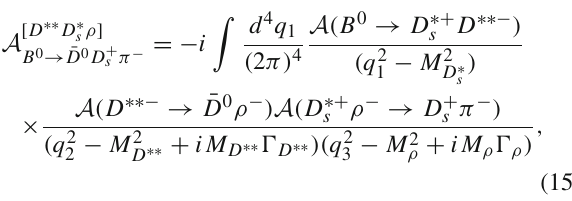
) (dashed line), and D ( 3000 ) J 1